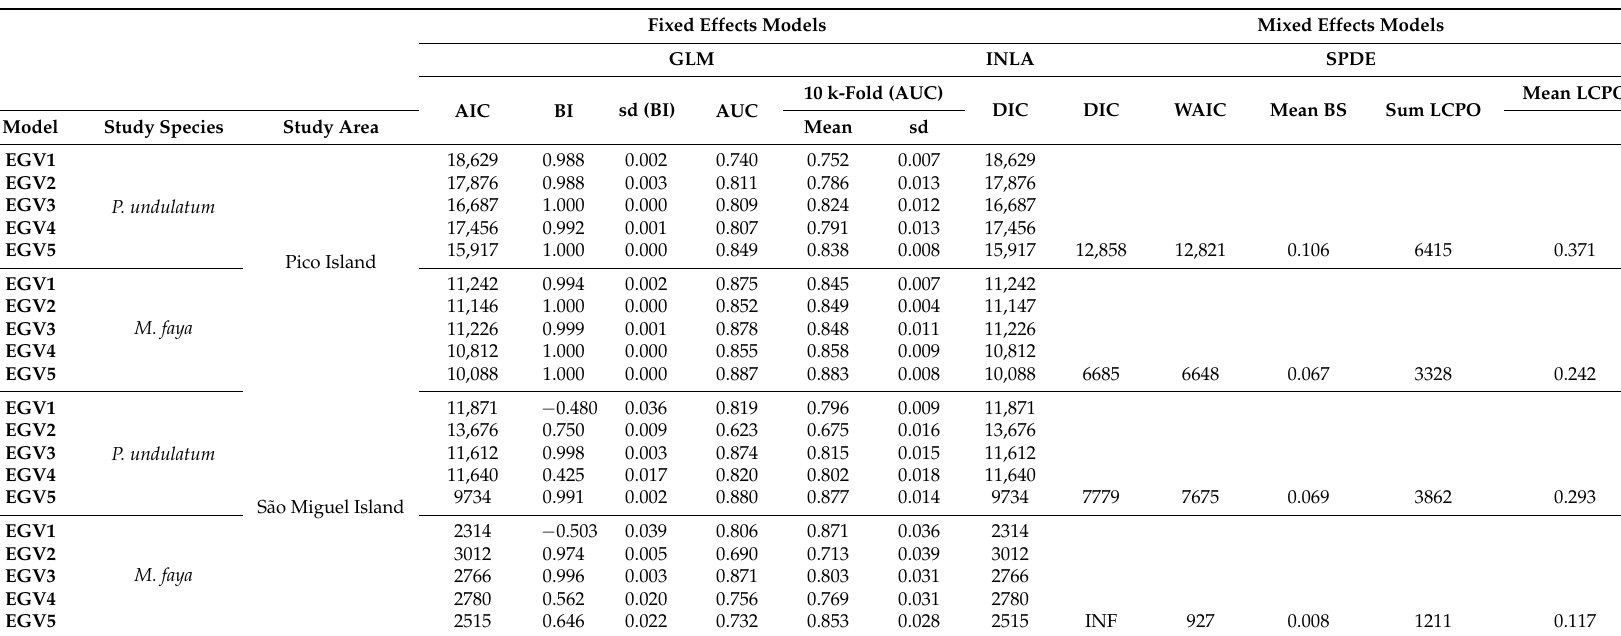
Table 4. Results of fixed and mixed effects models regarding different combinations of variables for P. undulatum and M. faya in Pico and S ã o Miguel islands. BI: Boyce Index; sd: standard deviation; BS: Brier